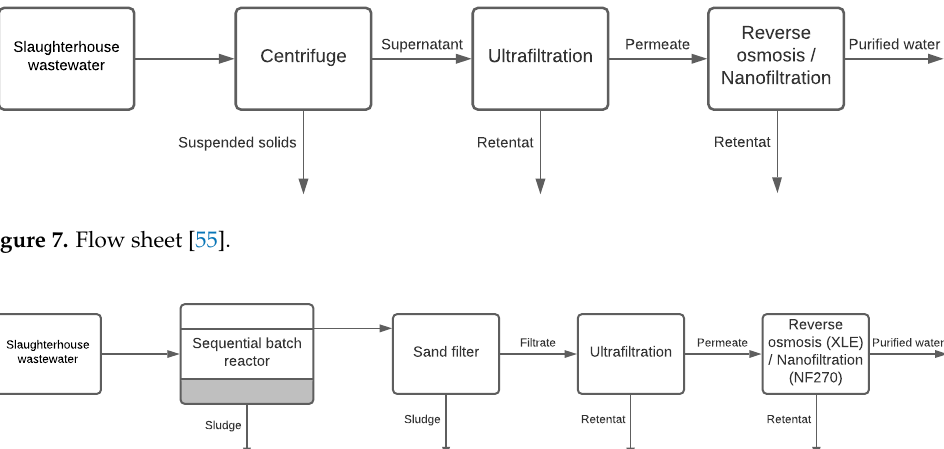
Figure 8. Flow sheet